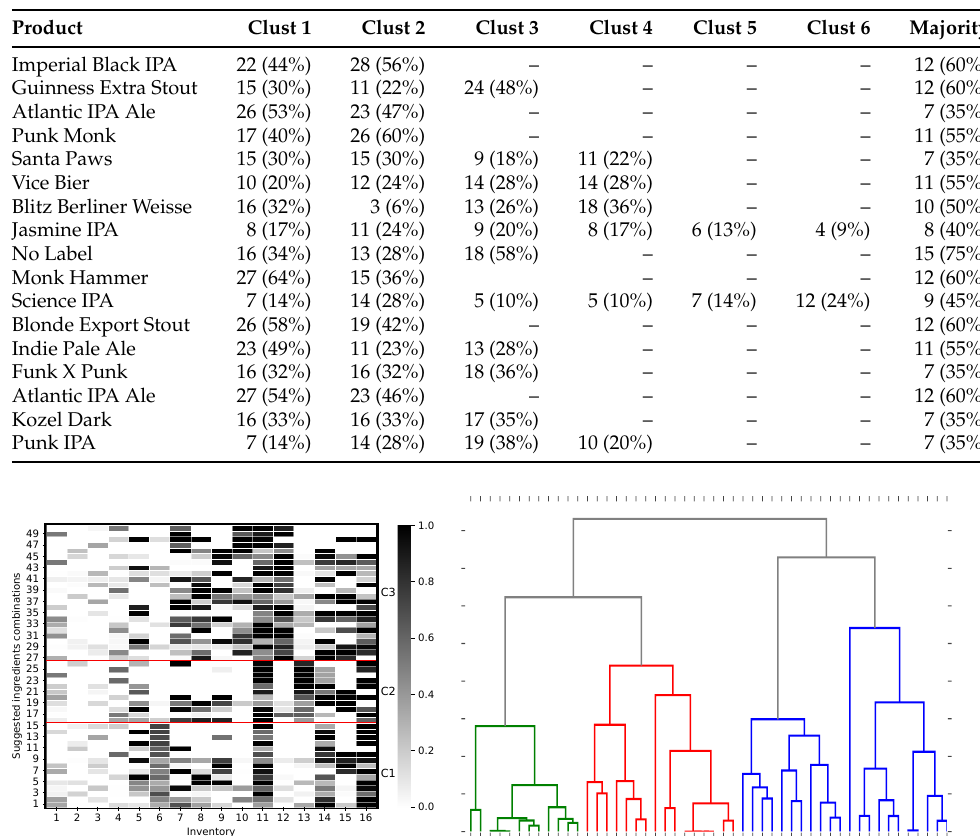
Figure 6. Strength of the possible number of clusters (based on the indices) in six products, where C = { 2,...,6 } represents the number of clusters. The strength of each proposed number of clusters is determined by taking into account 20 clustering indices. The complete set of charts are provided in Appendix A.2 in Figure A3. Table 6. Solution clusters. The figures present the total number of solutions in each cluster when the best clustering strategy (using majority rule) is used.